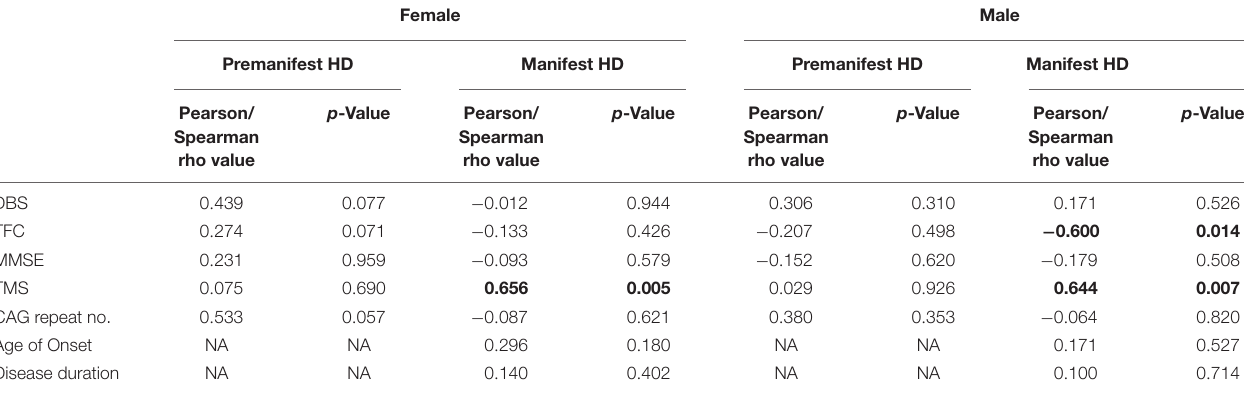
TABLE 2 | Correlations between plasma uric acid and clinical and disease data in female and male HD patients. Female Male Premanifest HD Manifest HD Premanifest HD Manifest